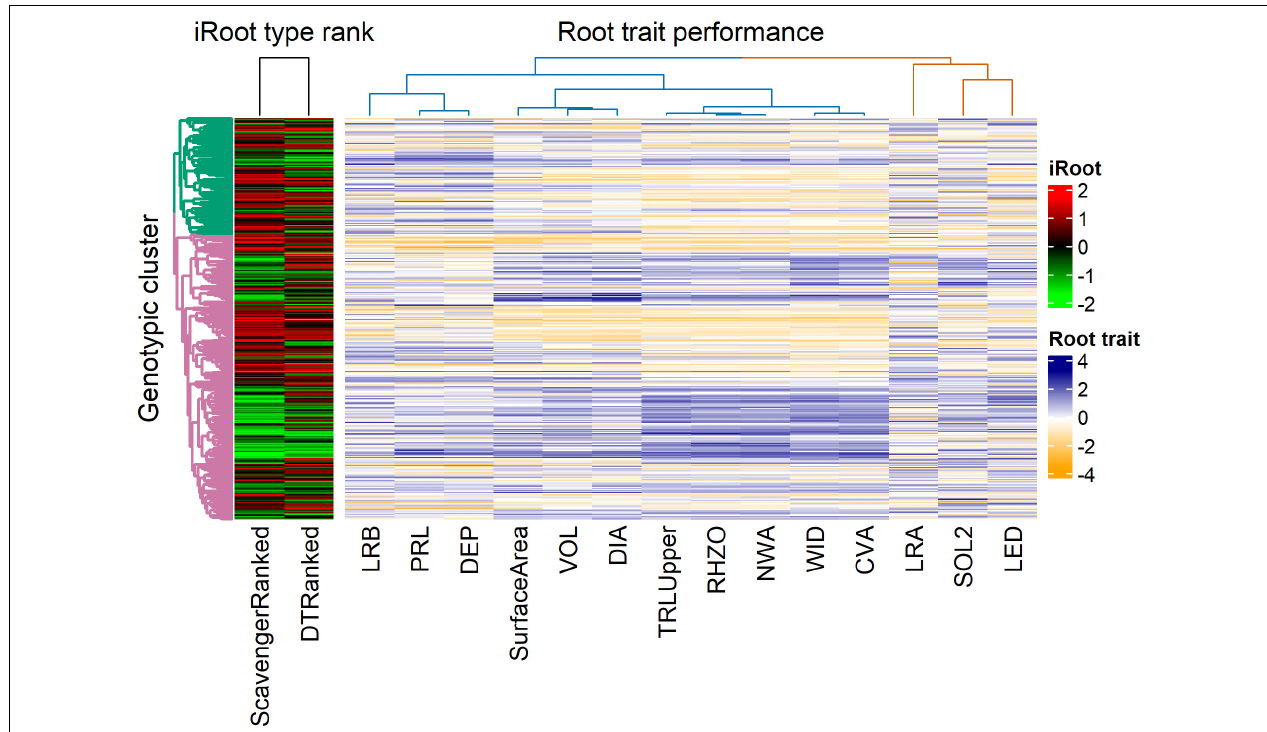
FIGURE 7 | Heat map revealing patterns between the genotypic clusters, iRoot category, and root traits performance for the genotypes in the IA mung bean panel. The dendrogram on the y-axis represents the genotypic clusters (green = 1 and pink = 2). The dendrograms on the top represent the iRoot category and root trait